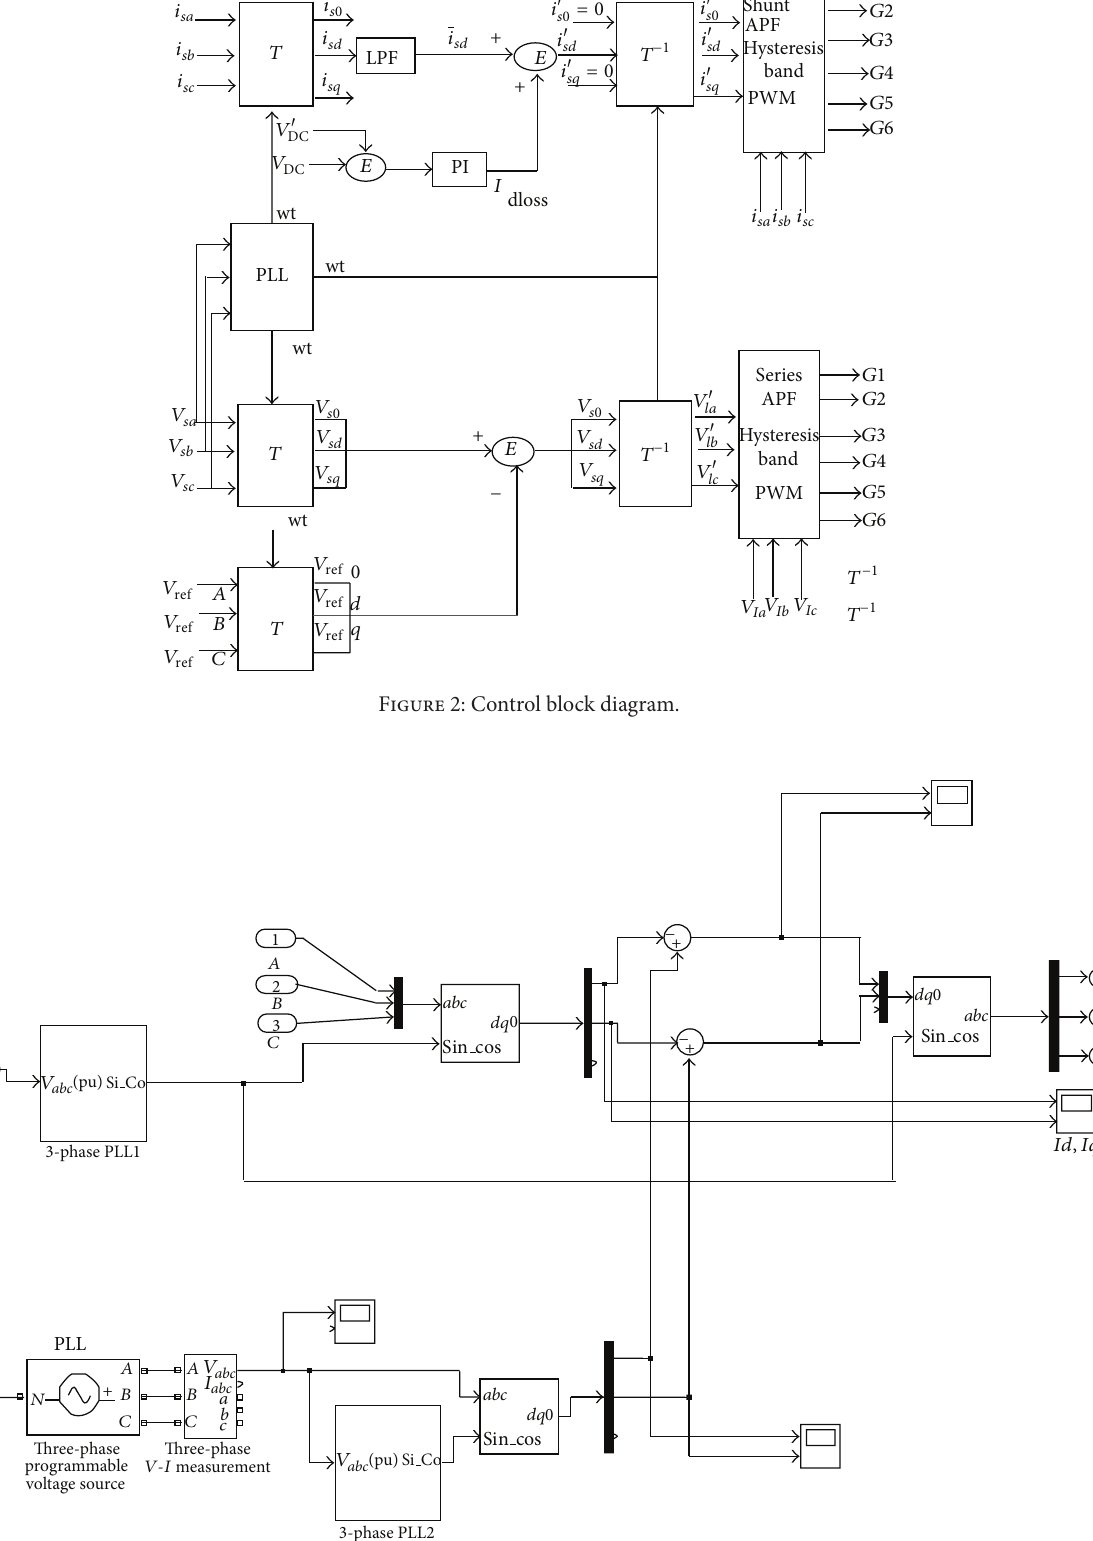
Figure 3: Simulation of synchronous reference frame theory based series